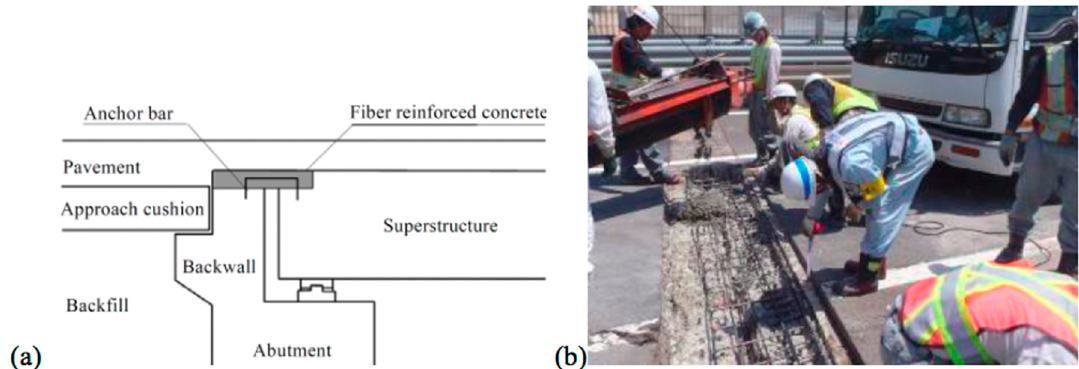
Figure 11. Schematic of an ( a ) FRC abutment-slab connection to prevent leakage and corrosion in highway infrastructure, and ( b ) casting of the FRC [162] .